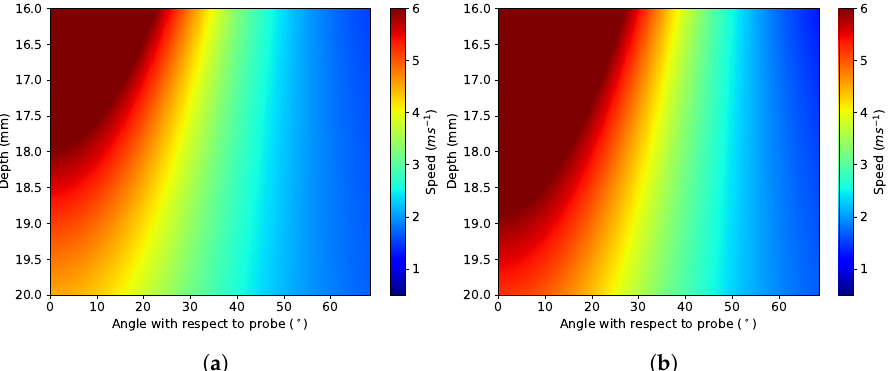
Figure 11. Simulated elastograms for the sample case based on the measured indentation and parameters for the ( a ) DF and ( b ) VW models.